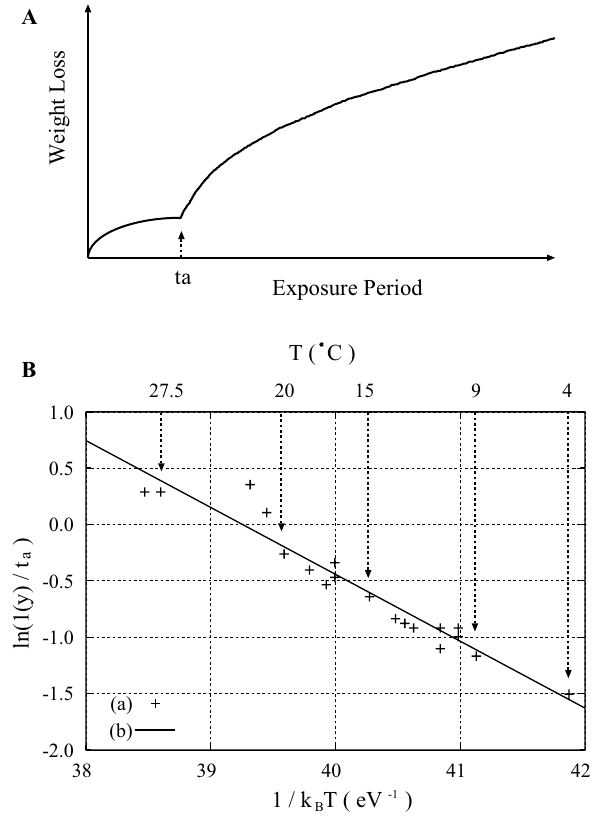
Figure 6. ( A ) Temporal evolution in the weight loss of the material by corrosion is schematically illustrated. The transition of the corrosion mode from the ’uniform’ corrosion to the pitting corrosion takes place at t a . ( B ) Arrhenius plot of the nucleation time in the pitting corrosion of the mild steel immersed with seawater. (a) Experimental data after Melchers and Chernov 30 . (B) The line ln ( 1 ( y )/ t a ) (eV) obtained by applying the LSF to the experimental data in